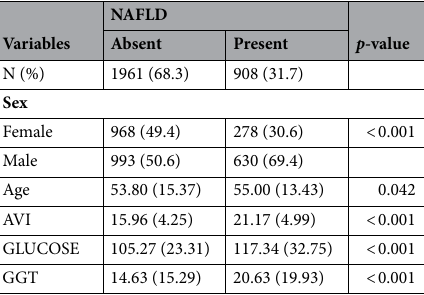
Table 2. Sample subset characteristics by NAFLD condition. MICOL study, Castellana Grotte (BA), Italy, 2005. Cells reporting subject characteristics contain mean (± SD) or n (%).